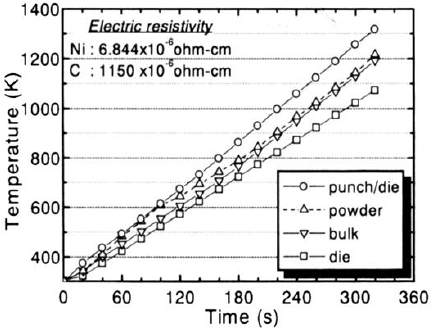
Figure 16. The temperature difference between specimen and graphite die.